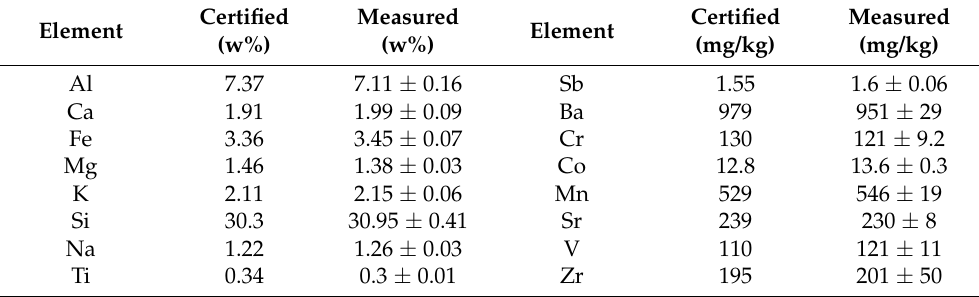
Table A2. The certified as well as experimentally determined mass fractions of the NIST 2709 CRM elements.